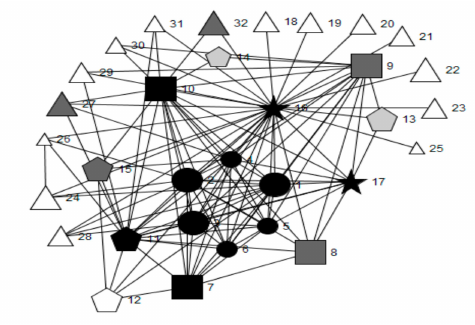
Figure 3. Net-map of wellbeing lead’s ego network for Oakwood School.